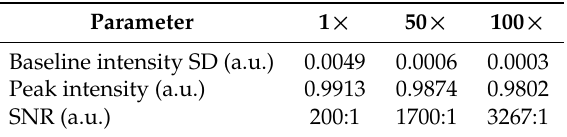
Table 4. Standard deviation, peak intensity and SNR of the spectrum of a tungsten halogen lamp source with 1, 50 and 100